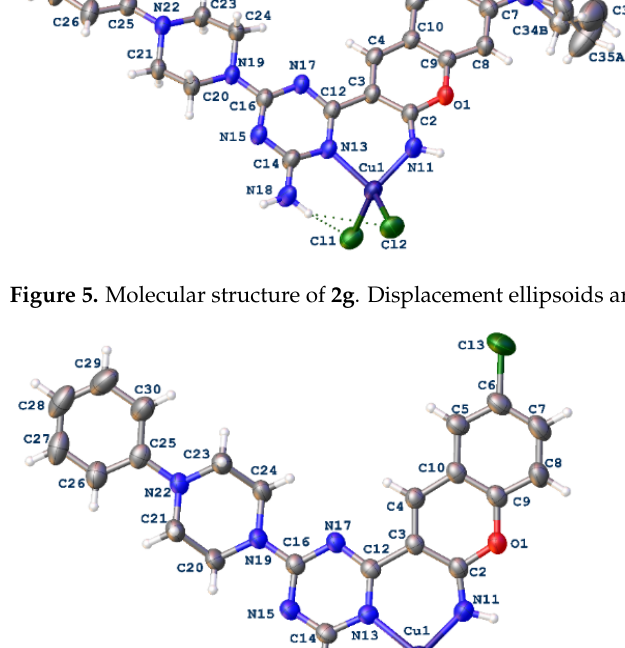
Figure 6. Molecular structure of 2h . Displacement ellipsoids are shown at the 50% probability level.